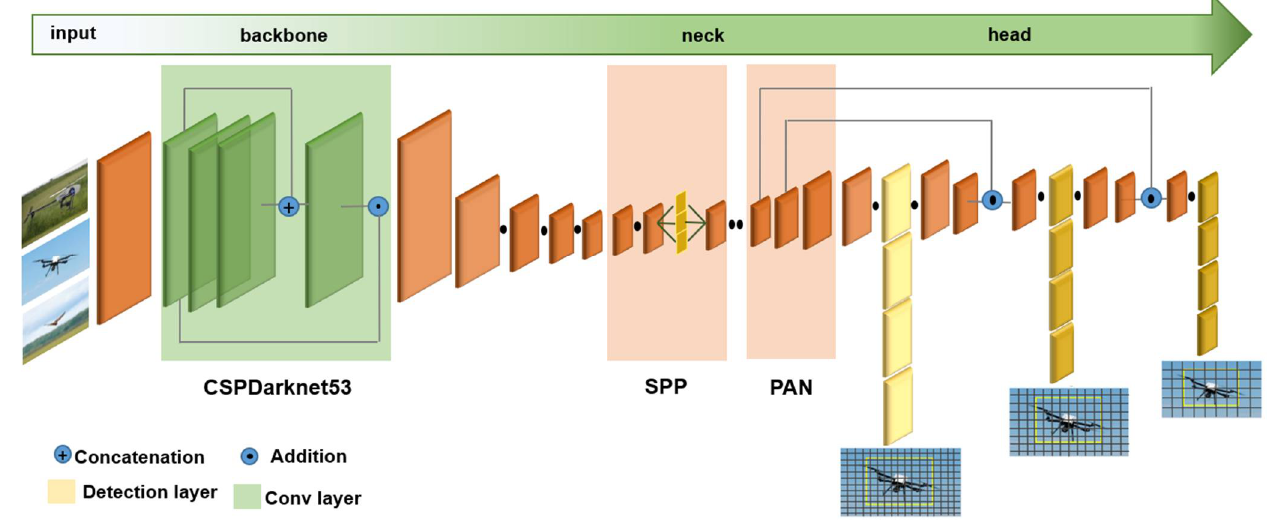
Figure 8. The architecture of the proposed deep learning network.